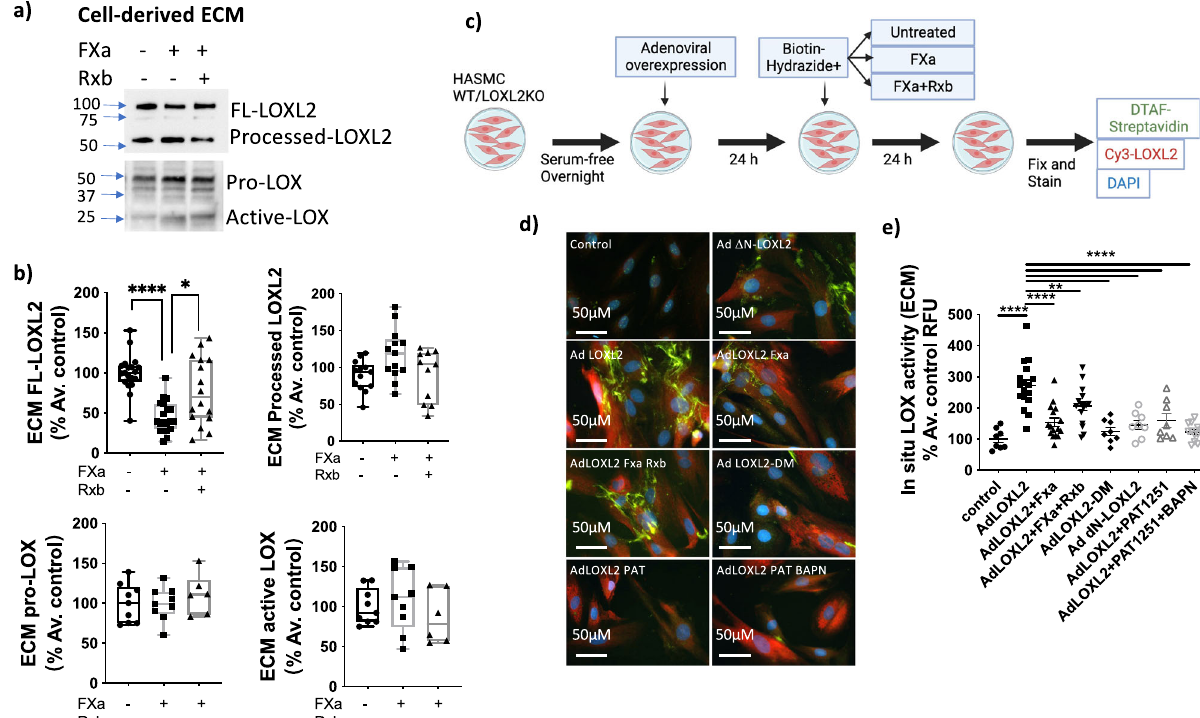
Fig. 6 LOXL2 processing by FXa reduces total LOX activity in the cell-derived ECM. a Representative Western blot and b densitometry analysis showing full-length and processed LOXL2 and prototypical LOX in the cell-derived ECM with and without FXa treatment in the presence or absence of rivaroxaban ( n ≥ 6; mean ± SEM; * P < 0.05, **** P < 0.0001 by one-way ANOVA). c Schematic depicting the in situ activity assay protocol (Created using Biorender). d Representative confocal microscopy images of in situ LOXs activity (green), LOXL2 (red), and nuclei (DAPI, blue) for the following conditions: (1) control A7r5s cells, (2) Δ N-LOXL2 overexpression, (3) wild-type LOXL2 overexpression (4) LOXL2 overexpression with FXa incubation (1 μ g/ml), (5) LOXL2 overexpression with FXa (1 μ g/ml) and rivaroxaban (50 nM) incubation, (6) catalytically inactive LOXL2-DM overexpression, (7) LOXL2 overexpression + LOXL2-speci fi c inhibitor PAT-1251 (10 µ M), (8) LOXL2 overexpression + inhibitors BAPN (10 µ M) + PAT-1251 (10 µ M). (Scale bar = 50 μ m). e Activity signal in each IF image was converted to mean gray value shown in bar graph ( n ≥ 8; mean ± SEM; ** P < 0.01, **** P < 0.0001 by one-way